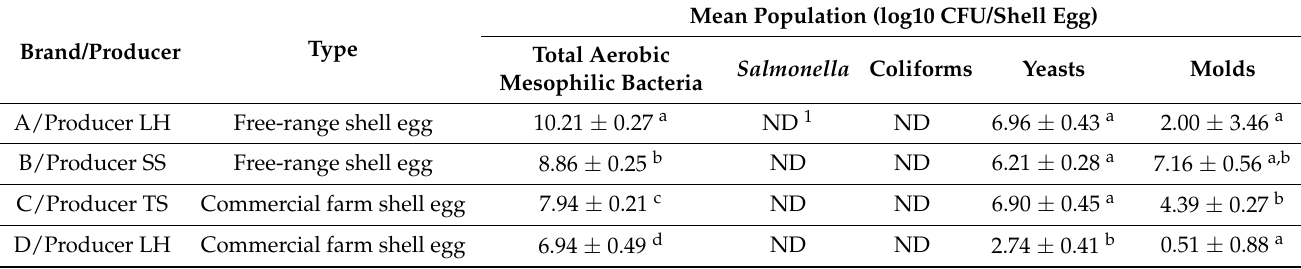
Table 4. Eggshell microbial load: mean ± SD of triplicate